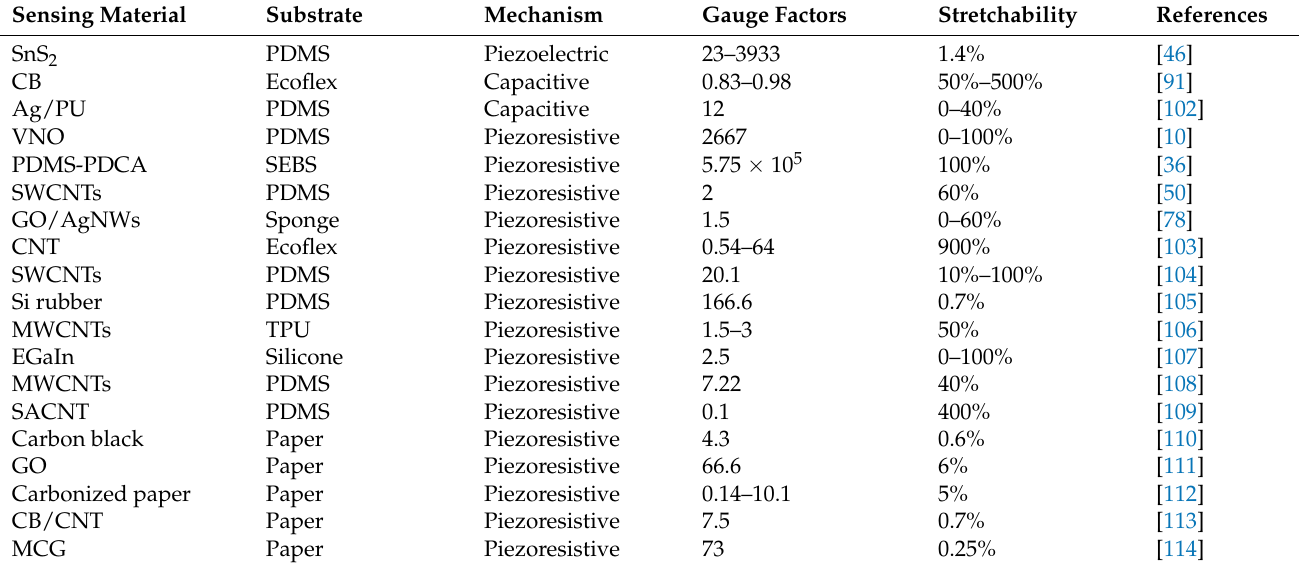
Table 2. Summary of main characteristic parameters of strain sensors based on sensing element and elastic